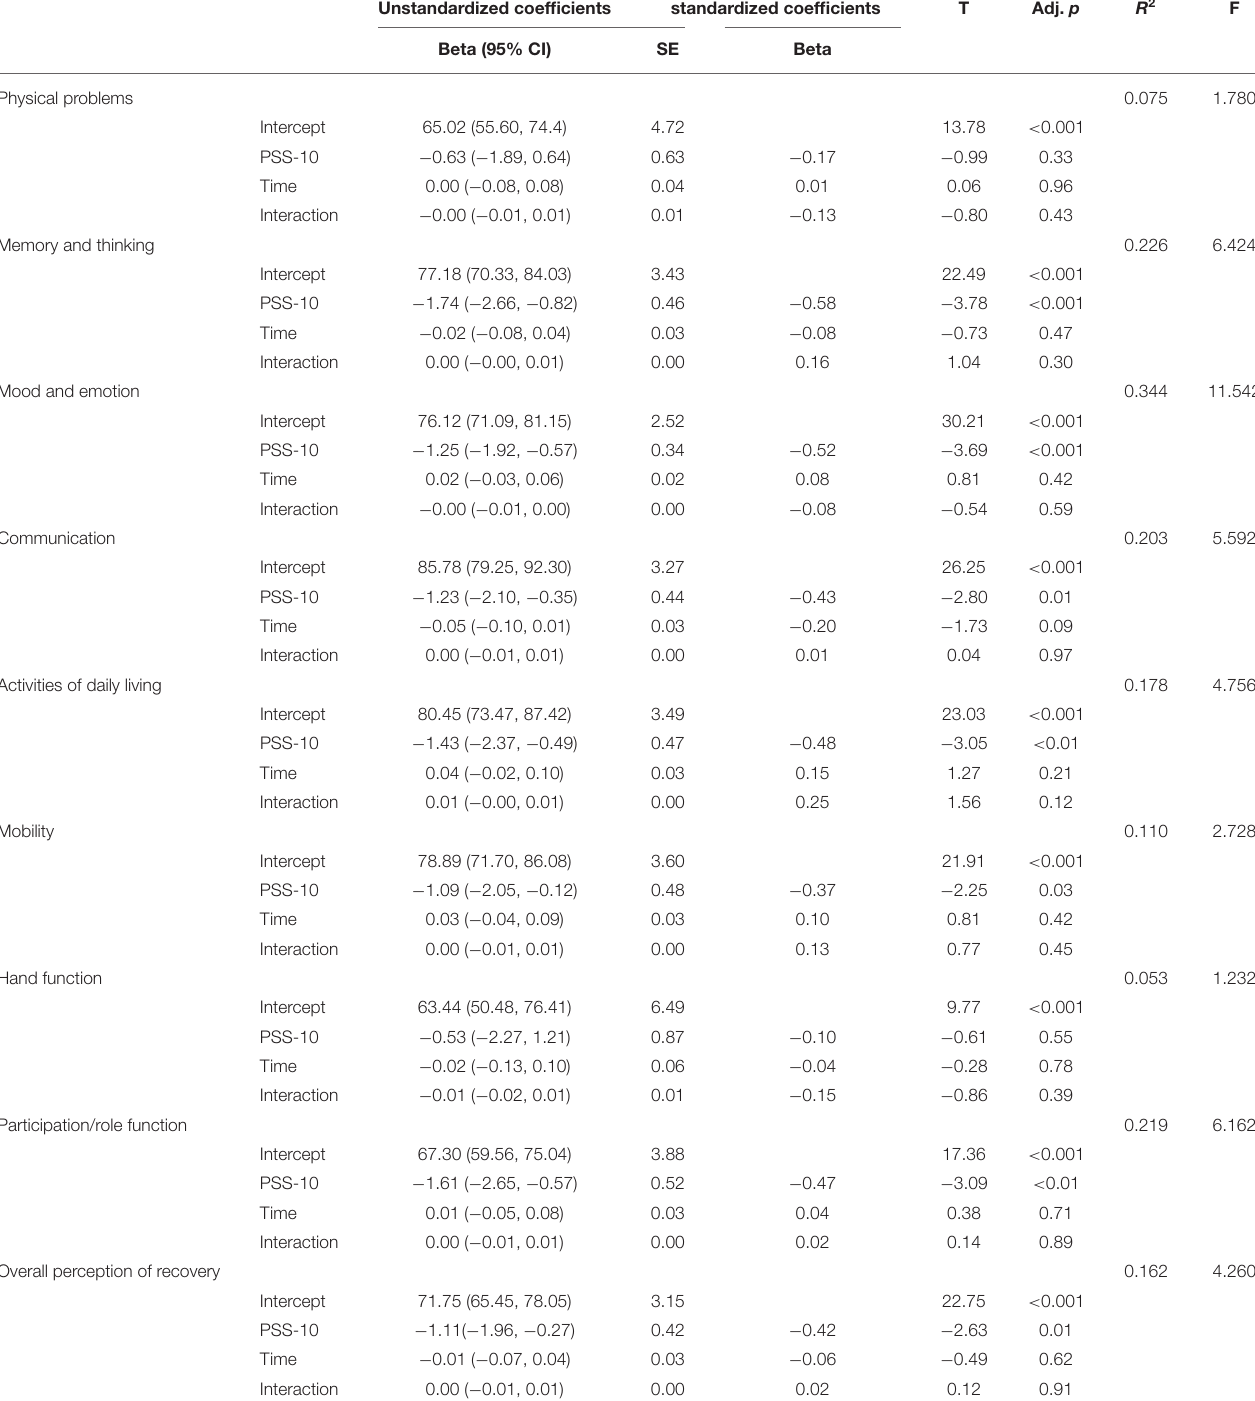
TABLE 7 | Multivariable linear regression analysis of interaction between time post stroke and perceived stress (PSS-10) on SIS